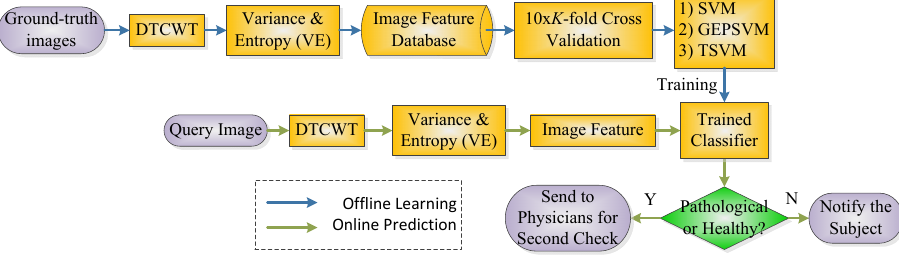
Figure 2. Modular framework of the proposed system for magnetic resonance (MR) brain classification ( K may be 5 or 6 according to the dataset).